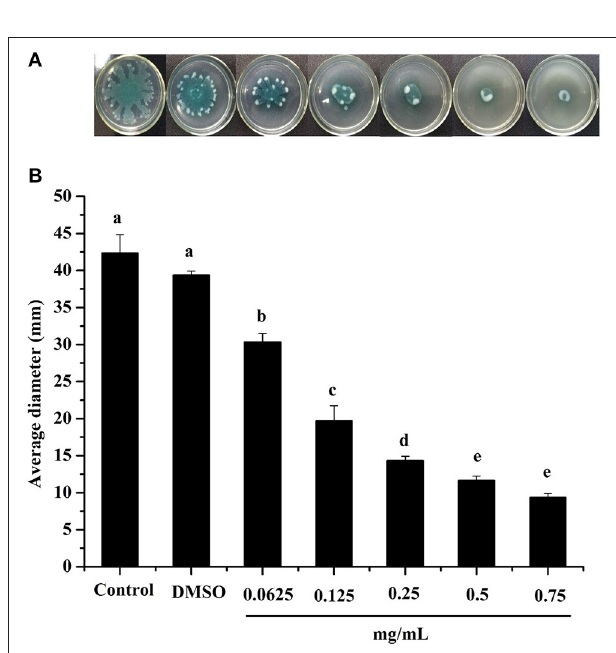
FIGURE 3 | Swarming inhibition assay. Swarming agar inoculated with the dichloromethane fraction of the Camellia nitidissima Chi flowers (A) , and average diameter of the bacterial colony tendrils (B) . Means with different small letters (a–e) are significantly different ( p < 0.05).